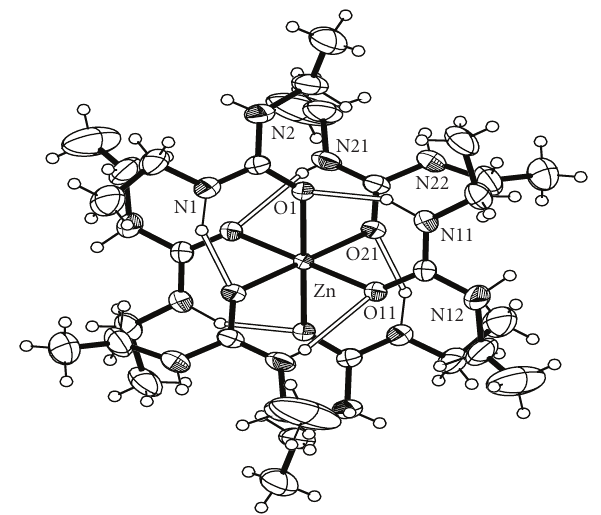
Figure 4: An ORTEP representation of the cation [Co(DEU) 6 ] 2+ present in complex 4 . Open bonds indicate intramolecular hydro- gen bonds. The symmetry-equivalent atoms are not labeled. Figure 5: A view of the 2D framework formed by hydrogen bonding between the [Zn(DEU) 6 ] 2+ cations and the ClO 4 − anions in 4 . The same framework is adopted by complexes 2 and 3